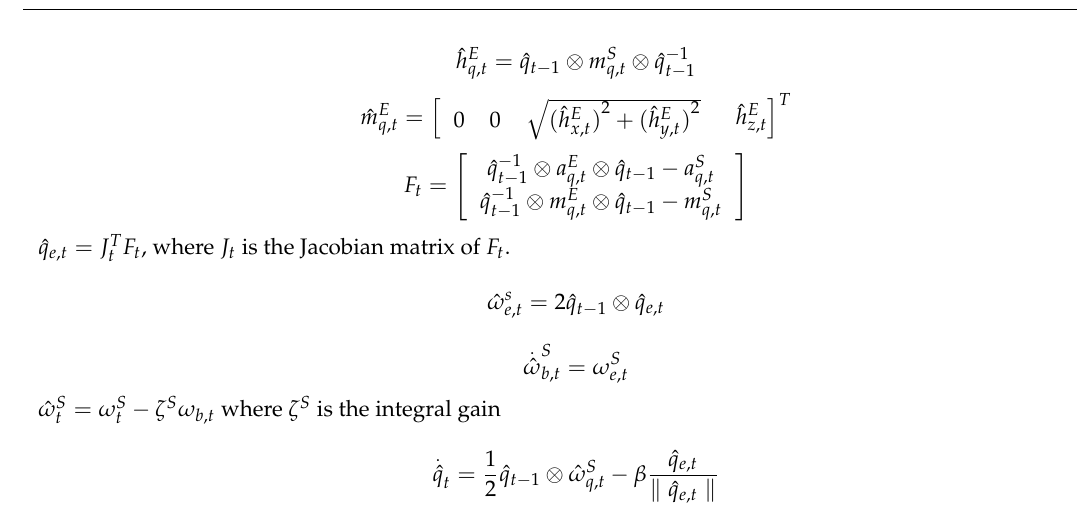
Algorithm 1. Gradient descent-based orientation filter.